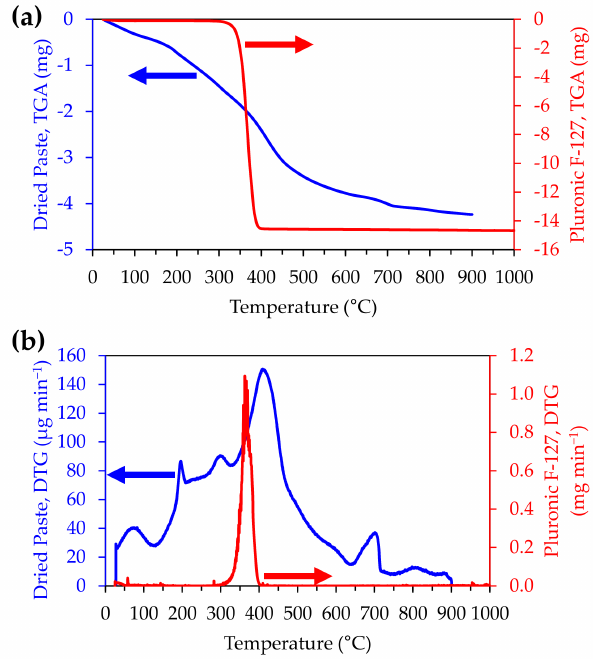
Figure 6. Comparative thermogravimetric analysis of pure Pluronic F-127 and of dried bioactive glass printing paste: ( a ) TGA, ( b )